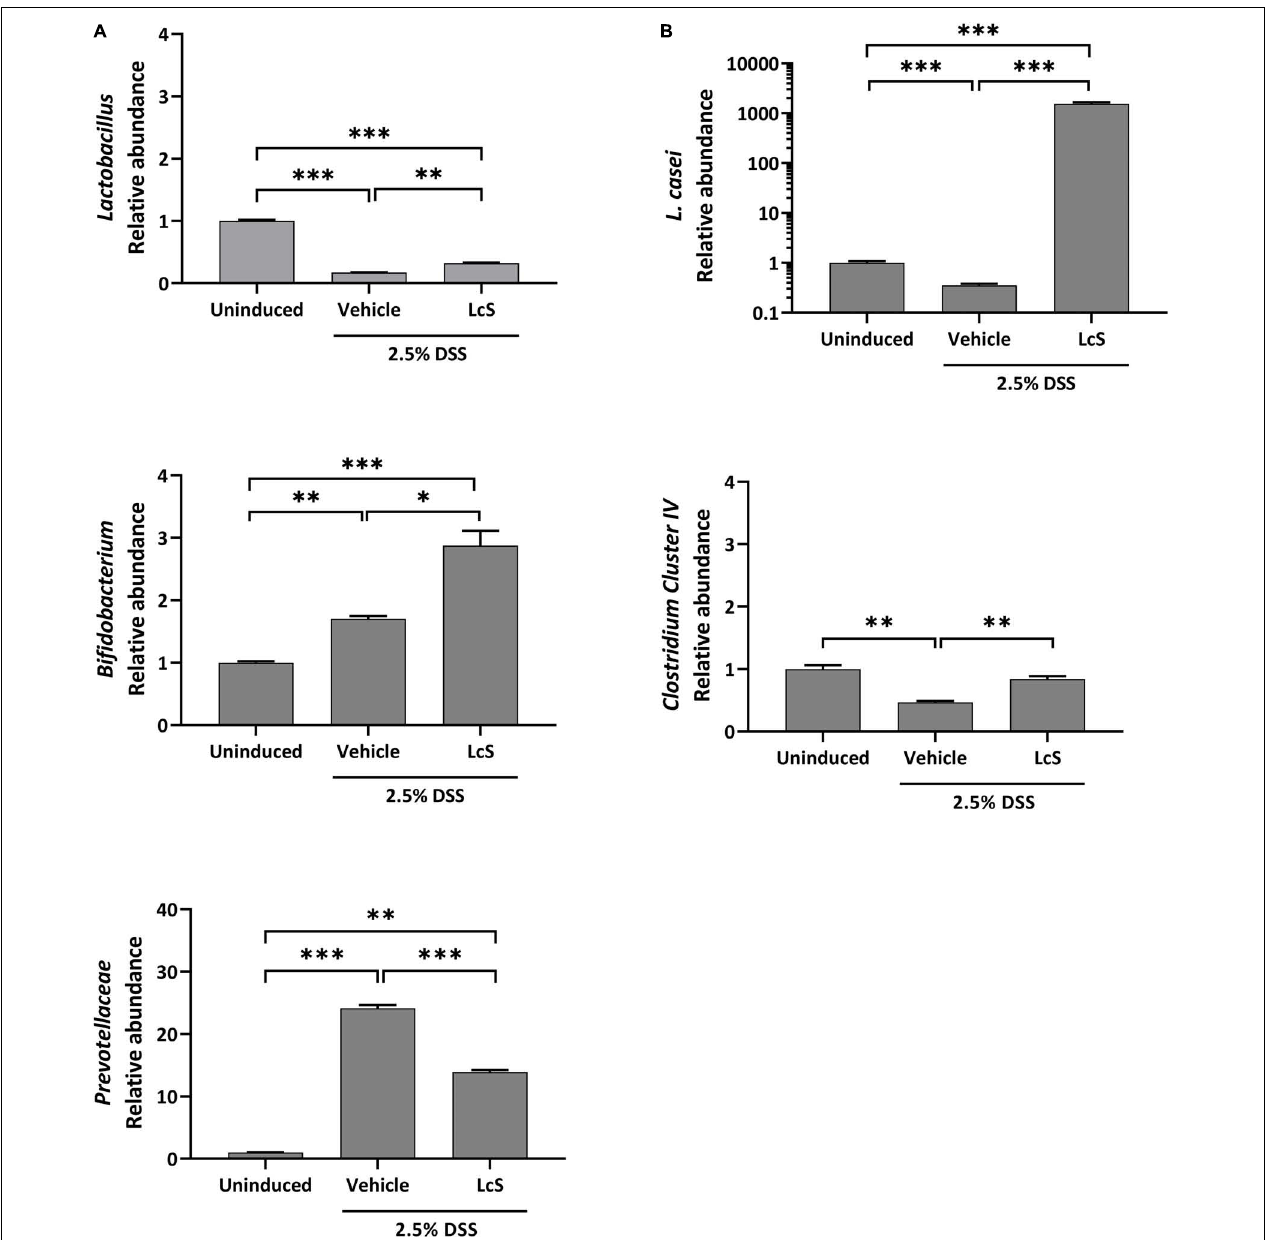
FIGURE 3 | LcS modulated gut microbiota in DSS-induced mice. Relative abundance of (A) Lactobacillus , Bifidobacterium , and Prevotellaceae , and (B) L. casei and Clostridium cluster IV in mice cecal contents. Bacterial abundances were normalized to DSS-induced mice. Data are expressed as mean ± SEM; ∗ p < 0.05, ∗∗ p < 0.01, ∗∗∗ p <